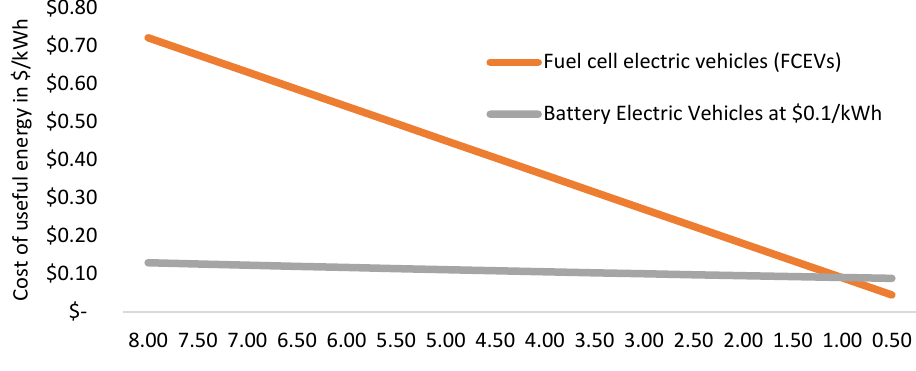
Figure 2. The cost of useful energy in USD/kWh used to move the BEVs and FCEVs [60 – 75].